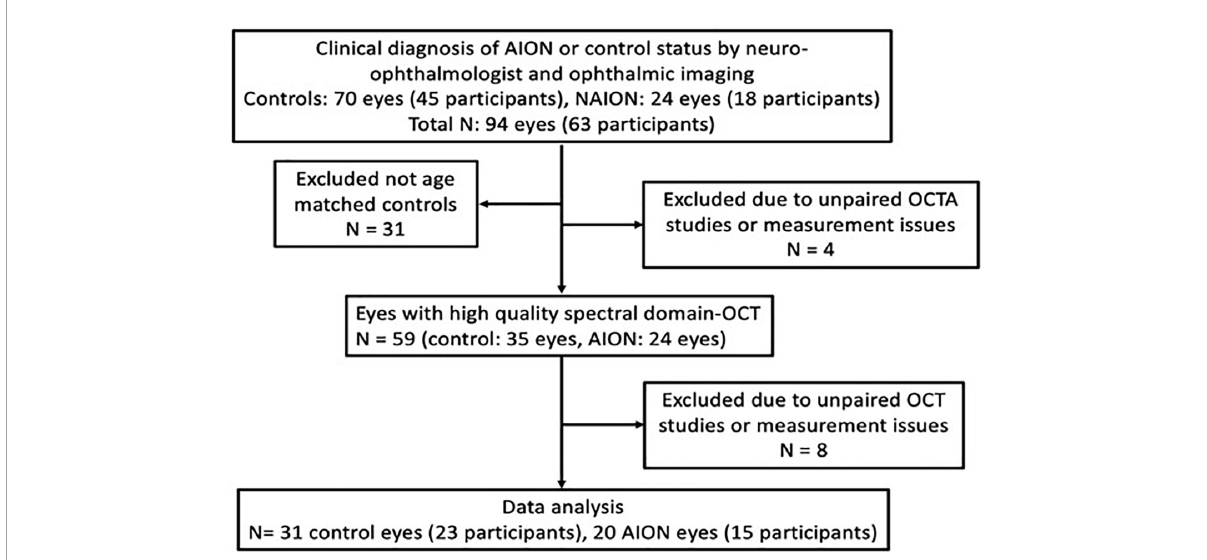
FIGURE1 Patient selection flow chart for chronic non-arteritic anterior ischemic optic neuropathy (NAION) ( ≥ 6 months from onset) and healthy controls.